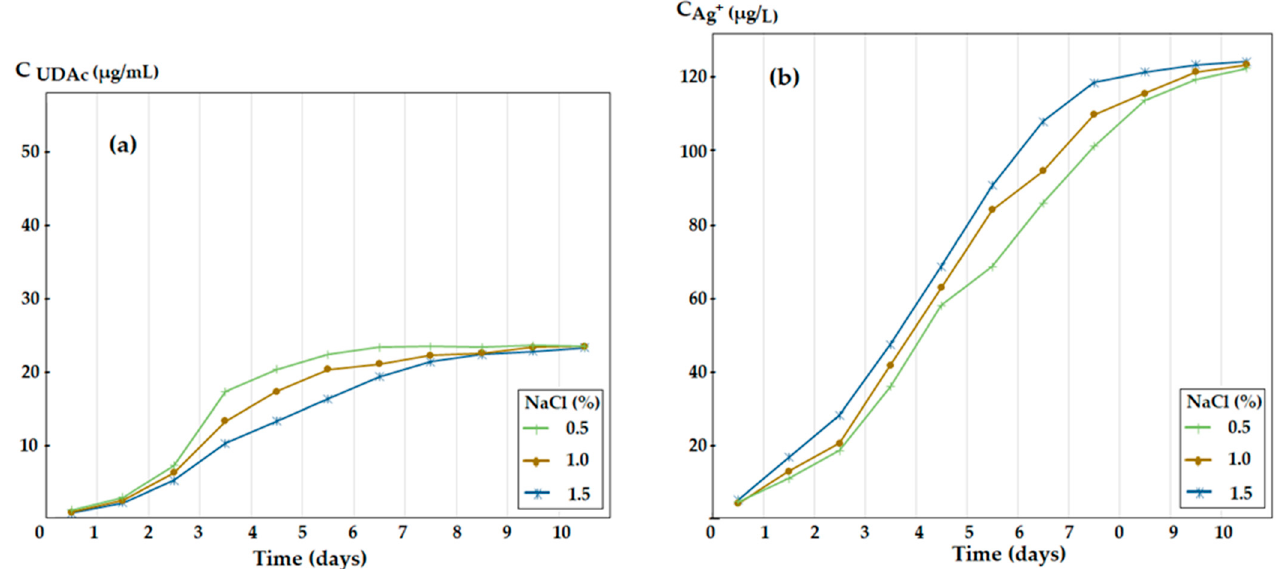
Figure 11. Concentration of 10–undecenoic acid ( a ) and of silver ions ( b ) released in the receiving aqueous phase, of variable ionic strength (NaCl), depending on the type of contact.